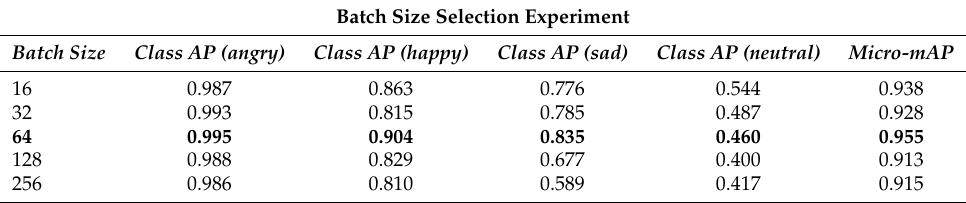
Table 6. Performance of the proposed architecture with different batch